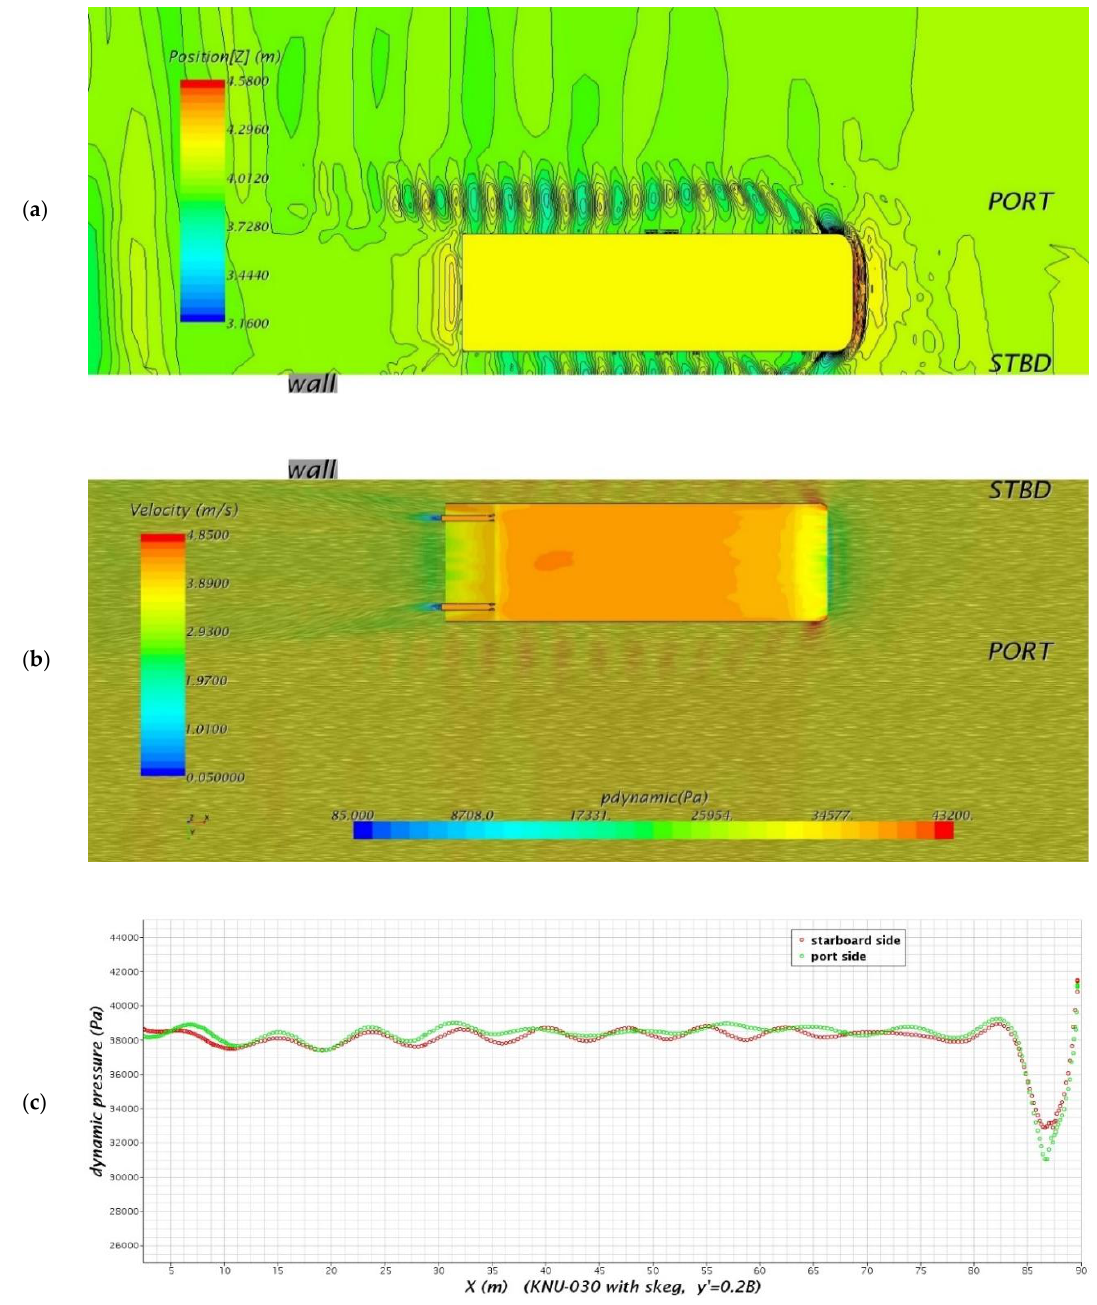
Figure 9. Simulation results for KNU-030 at y′ = 0.2 B : ( a ) wave pattern; ( b ) velocity field with line integral convolution and hydrodynamic pressure distribution on the bottom; and ( c ) hydrodynamic pressure on the starboard and port side.